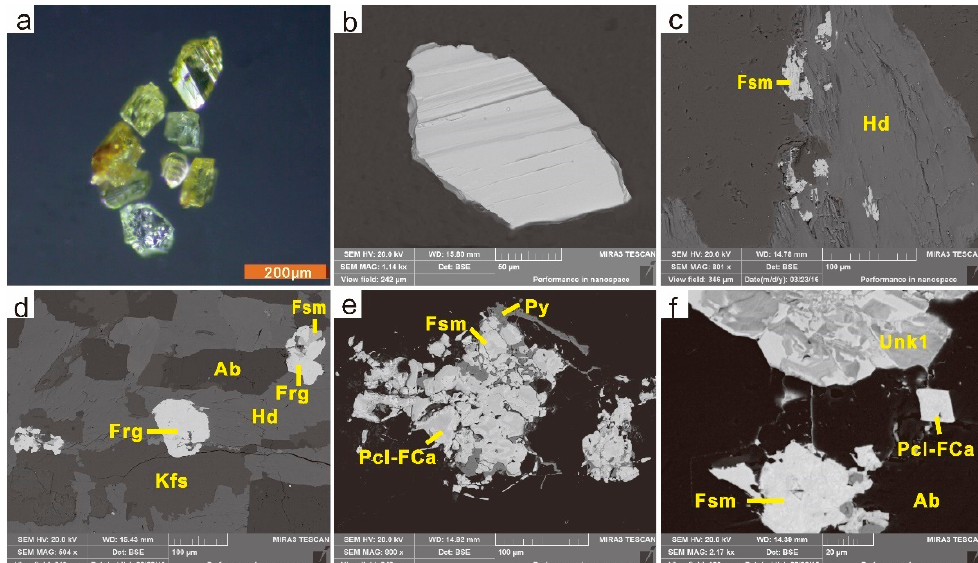
Figure 7. Photomicrographs and BSE images of fersmite with associated minerals. ( a ) Fersmite crystals; ( b ) a fersmite crystal (BSE) showing uniform composition distribution; ( c ) anhedral fersmite (BSE) distributed around hedenbergite; ( d ) subhedral fersmite associated with fergusonite-(Y) (BSE); ( e ) fersmite partly replaced by fluorcalciopyrochlore (BSE); and ( f ) an irregular aggregate of fersmite associated with fluorcalciopyrochlore (BSE). Abbreviations: Ab—albite; Frg—fergusonite-(Y); Fsm—fersmite; Hd—hedenbergite; Kfs—K-feldspar; Pcl-FCa—fluorcalciopyrochlore; Py—pyrite; Unk1—unknown mineral 1; and